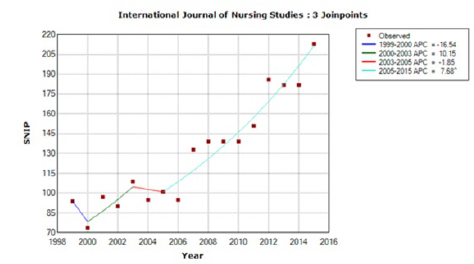
Figure 3 Trend model for the Journal of Advanced Nursing (JAN)